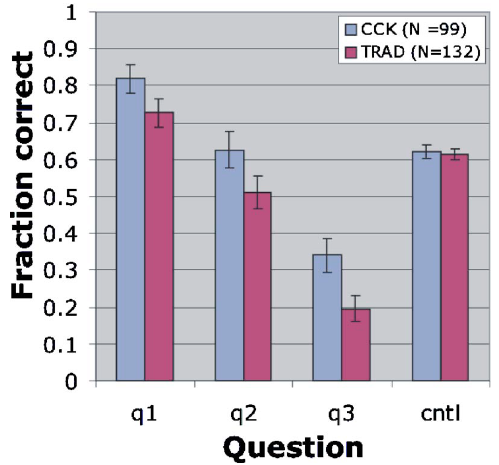
FIG. 5. (cid:1) Color (cid:2) Student performance on three final examination dc circuits questions (cid:1) q1, q2, q3 (cid:2) and the remaining 26 questions on the exam (cid:1) cntl (cid:2) , for each of two conditions: students who had con- ducted the circuits lab with virtual (cid:1) CCK (cid:2) or real equipment (cid:1) TRAD (cid:2)